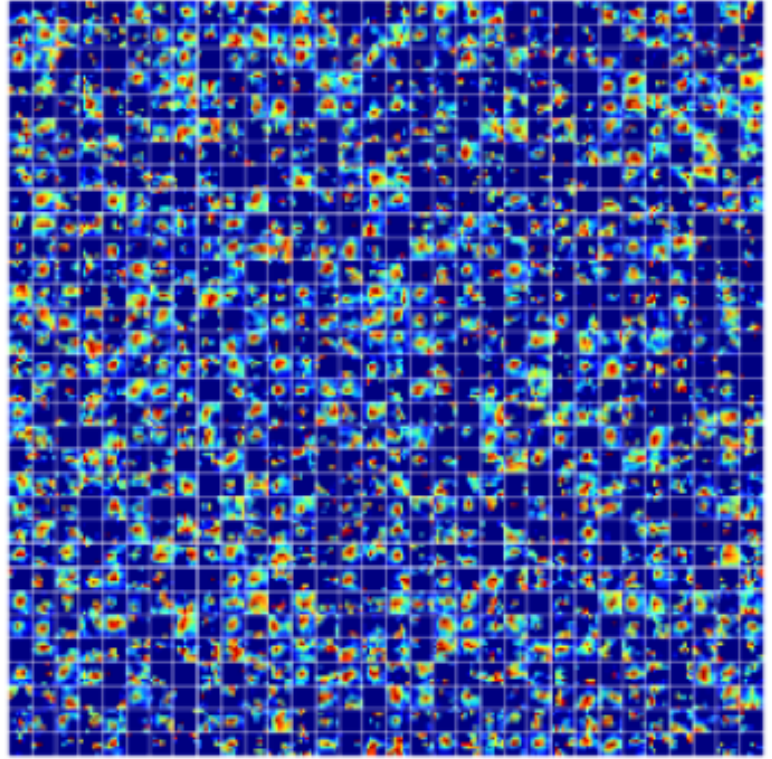
Figure 19. Visualization of the deep feature